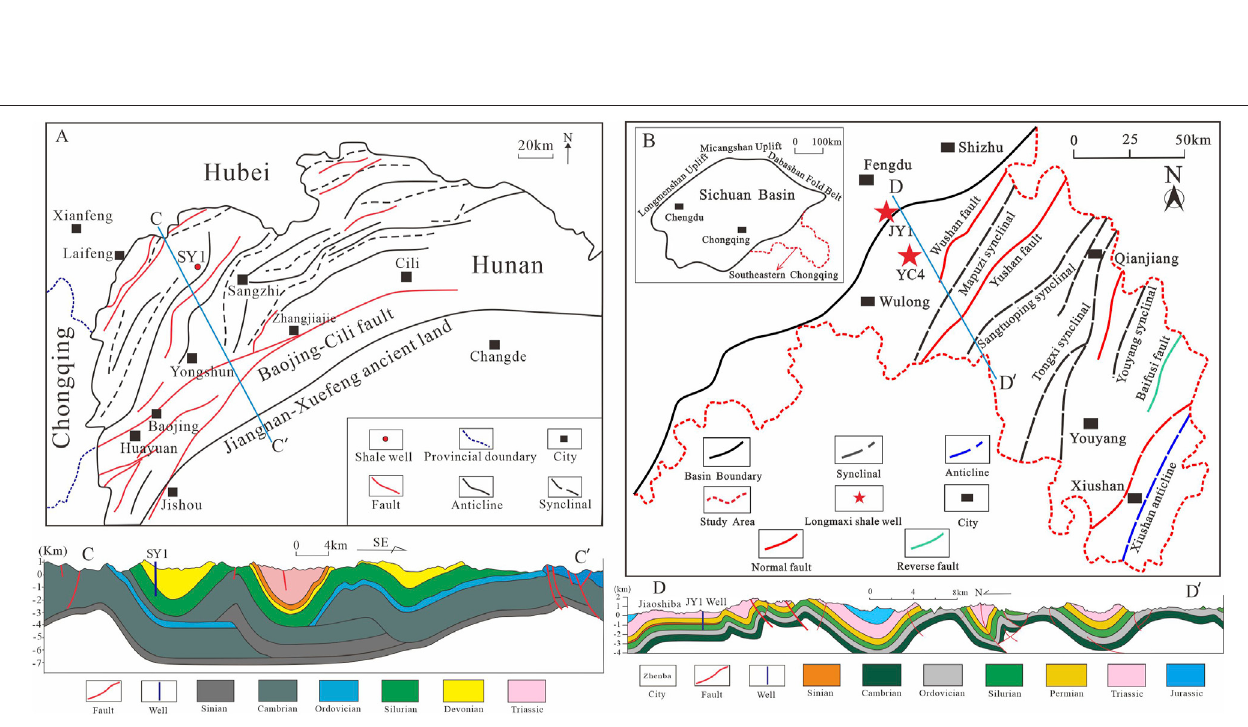
Frontiers in Earth Science |